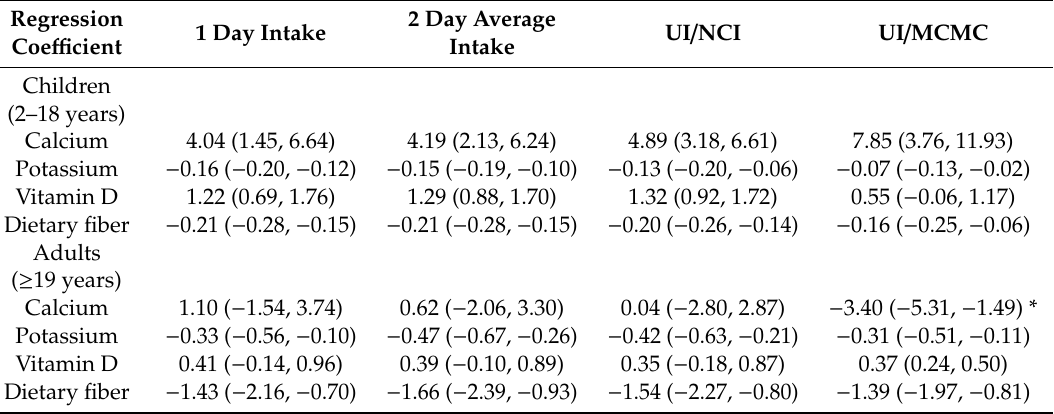
Table 6. Comparison of regression coe ffi cients for the percentage below the Estimated Average Requirement / above the Adequate Intake by di ff erent methods of added sugars intake, the